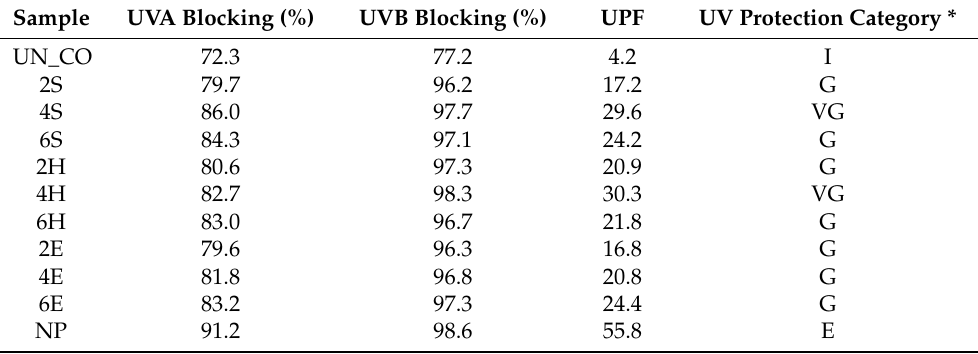
Figure 6. Transmission ( a ) and reflection ( b ) of untreated and TiO 2 functionalized cotton fabric sam- ples. Table 2. UPF values and UVA and UVB blocking % of untreated and TiO 2 functionalized cotton fabric